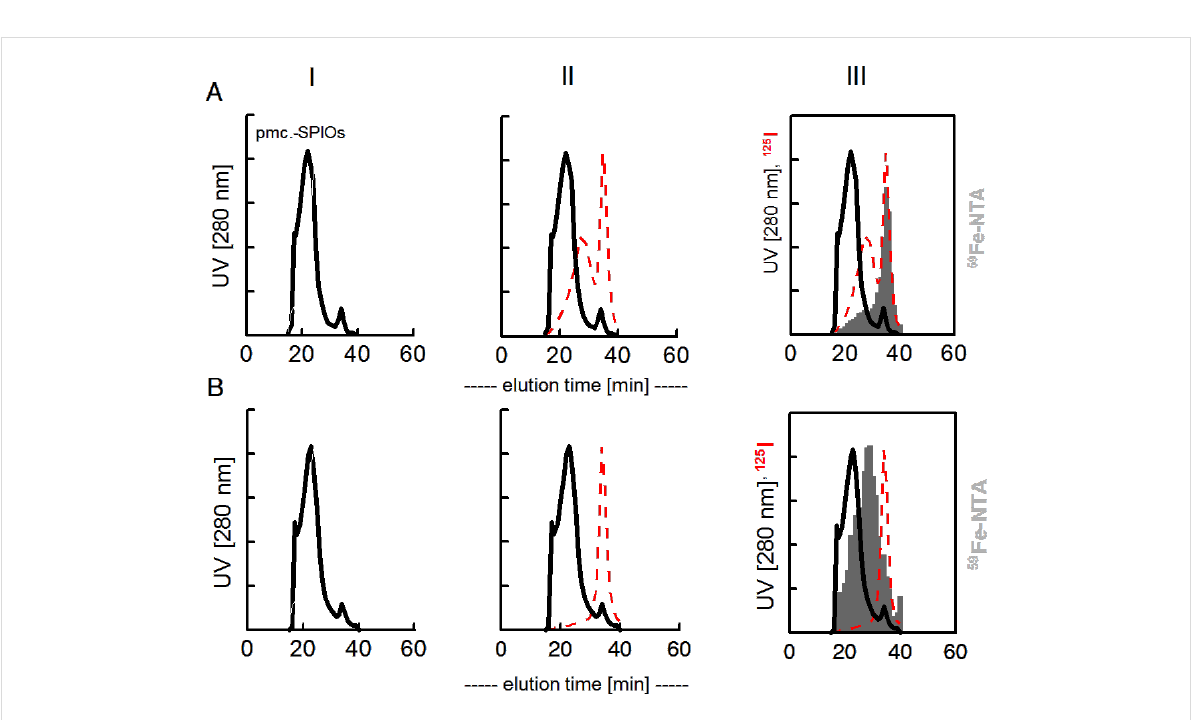
Figure 4: Stability of transferrin from a preformed corona on the polymer-coated, negatively charged nanoparticle. FPLC-chromatograms: I, upon transferrin binding the SPIOs with a hydrodynamic diameter of 25 nm increased the volume to about a diameter of 35 nm; II, a second incubation with 125 I-albumin resulted in additional binding of 125 I-albumin, III, labelling of transferrin on the SPIOs by incubation with 59 Fe-NTA (filled area). A, initial transferrin adsorbed; B, initial transferrin covalently bound. The peak at 33 min represents proteins with the size of transferrin (DLS: 9